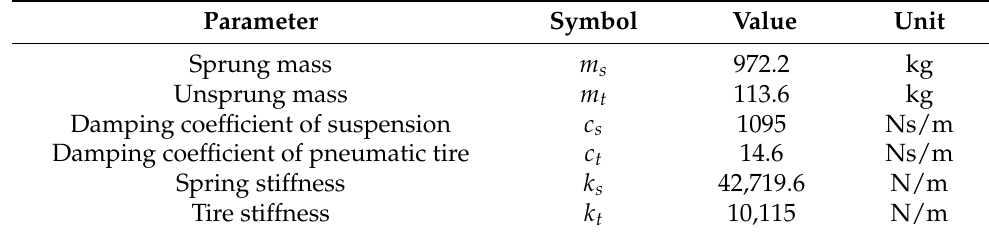
Table 4. Parameters for a 1/4 vehicle